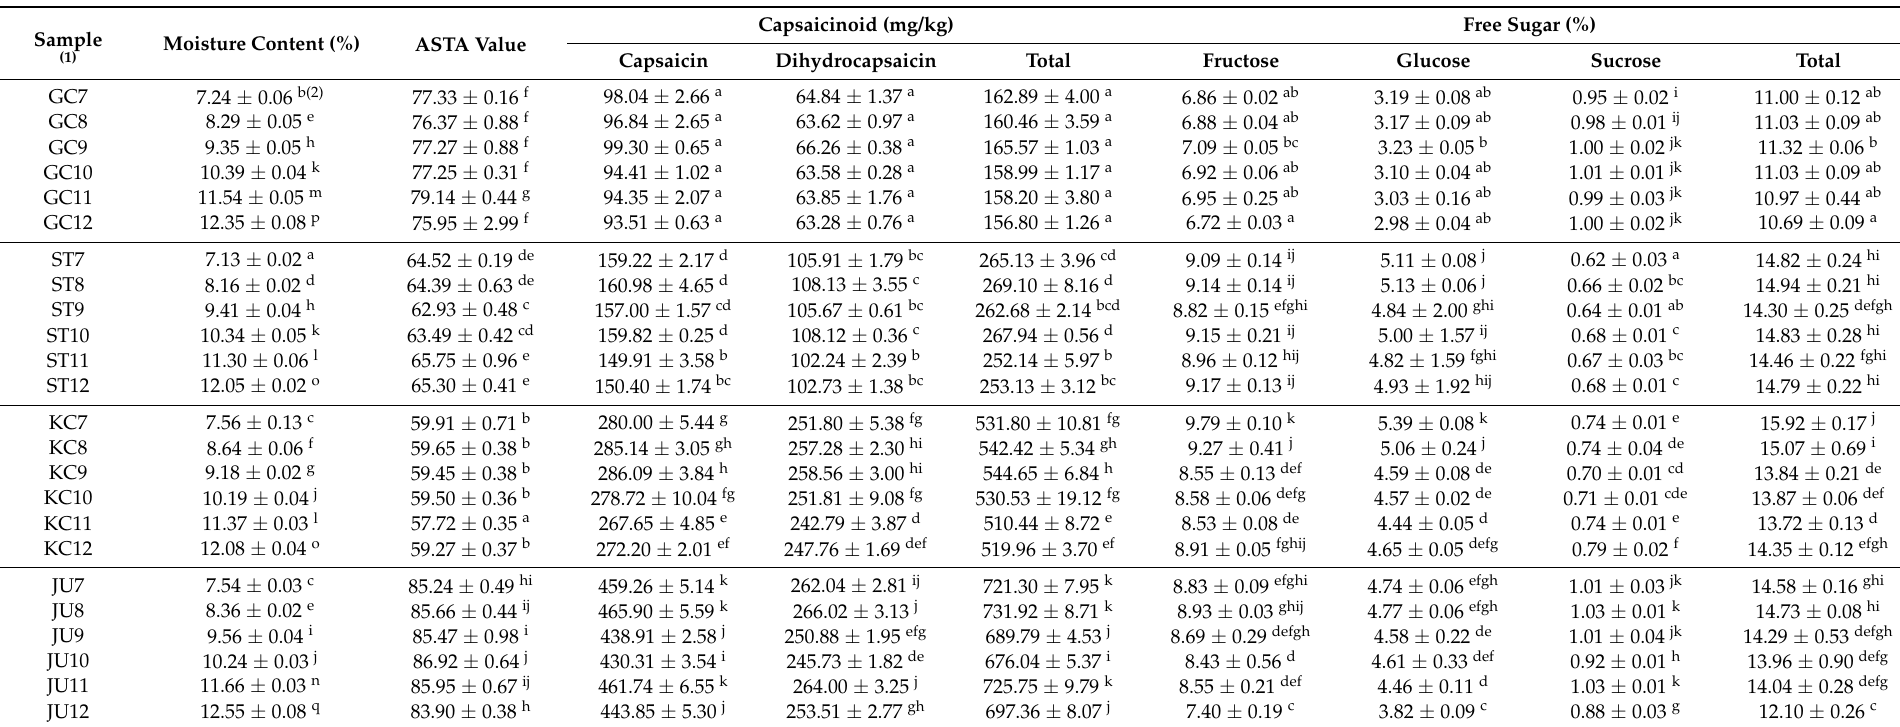
Table 2. Physicochemical properties of red pepper powder according to pungency level and moisture